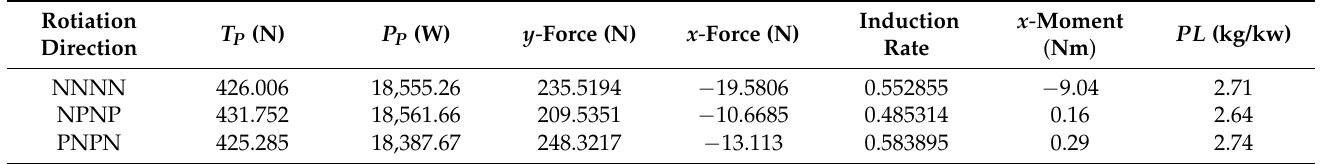
Table 3. Performance of four-propeller channel